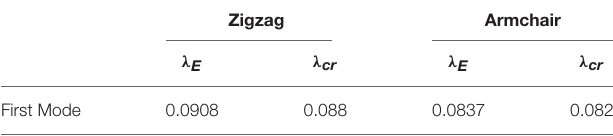
TABLE 2 | Comparison between critical